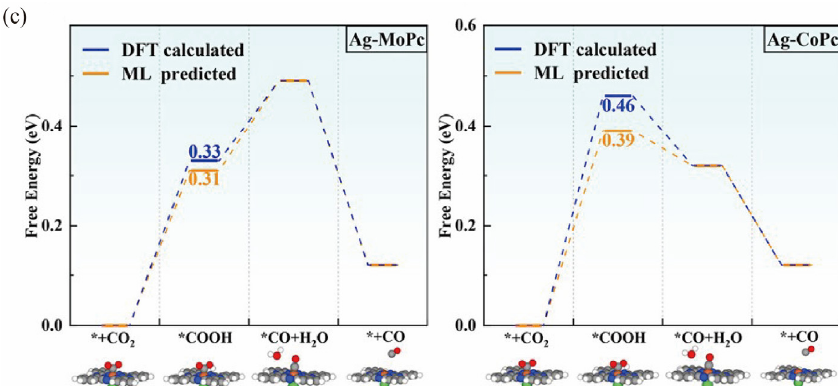
Figure 2. Applications of machine learning in high-throughput screening of high-performance electrocatalysts for CO 2 reduction. ( a ) Steps of machine learning for high-throughput screening. Adapted with permission from Ref. [68]. Copyright 2022, John Wiley and Sons. ( b ) Plots of CORR activity versus CO 2 RR/CORR selectivity for CoCuGaNiZn systems (left) and AgAuCuPdPt systems (right) predicted by Gaussian process regression. Reprinted with permission from Ref. [72]. Copyright 2020, American Chemical Society. CORR denotes CO reduction reaction. CO 2 RR/CORR selectivity is defined as the probability of surface sites with weaker or the same H adsorption strength as Cu. CORR activity is defined as the ability to reduce CO further, as the joint independent probability of surface sites with weaker or the same H adsorption strength as Cu and stronger or the same CO adsorption strength as Cu. ( c ) ML-predicted and DFT-calculated free energies of different reaction pathways for CO 2 RR to CO by Ag-MoPc (left) and Ag-CoPc (right). The * at the upper left of the substance name denotes that the substance is adsorbed on the surface of a catalyst. Reprinted with permission from Ref. [77]. Copyright 2021, American Chemical Society.